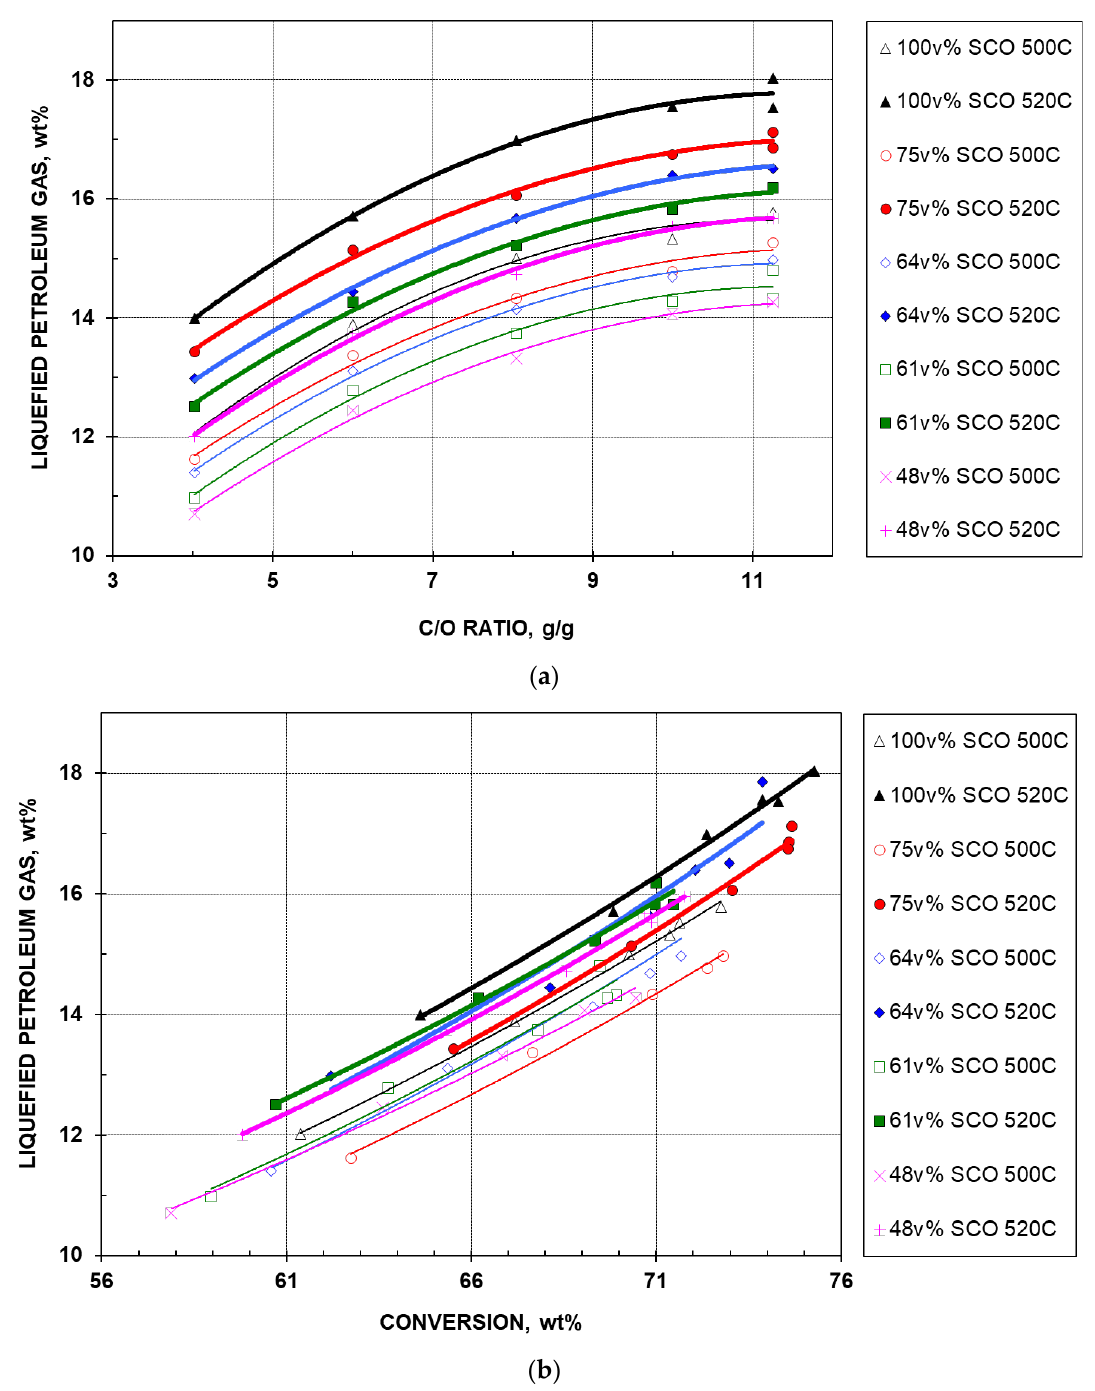
Figure 3. ( a ) LPG yield vs. C/O ratio at two reaction temperatures; ( b ) LPG yield vs. conversion at two reaction temperatures.